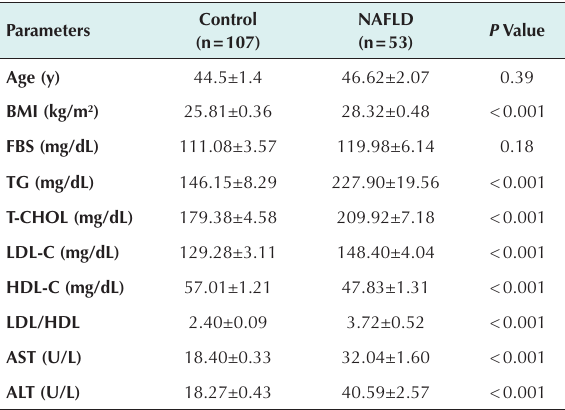
Table 1. Demographic and Clinical Characteristics of Case (NAFLD) and Control Groups